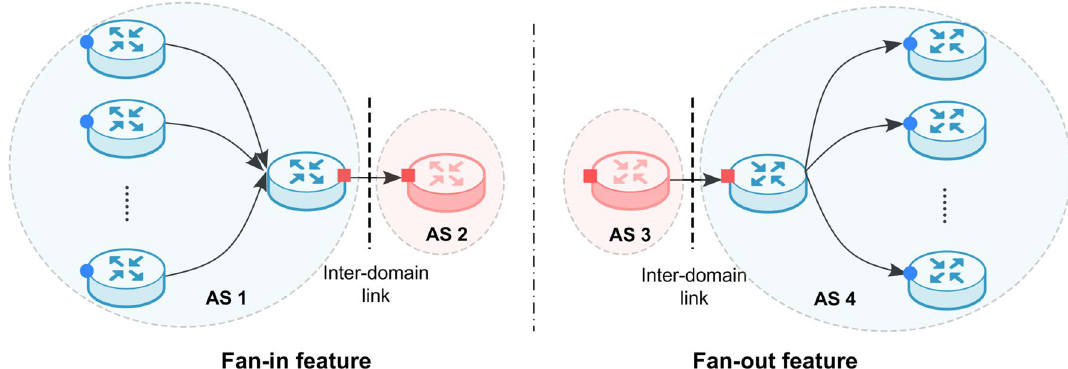
Figure 4. Illustrations of fan